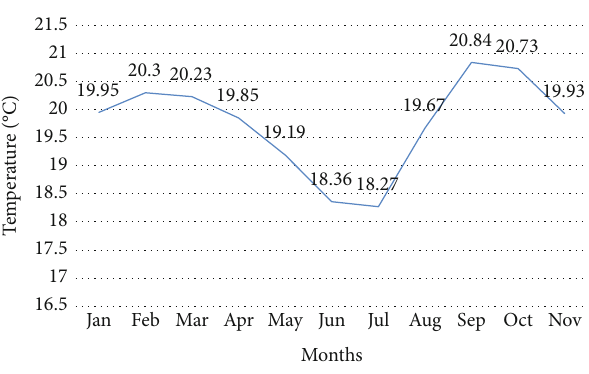
Figure 29: Solar PV trends in Burundi by IRENA. Figure